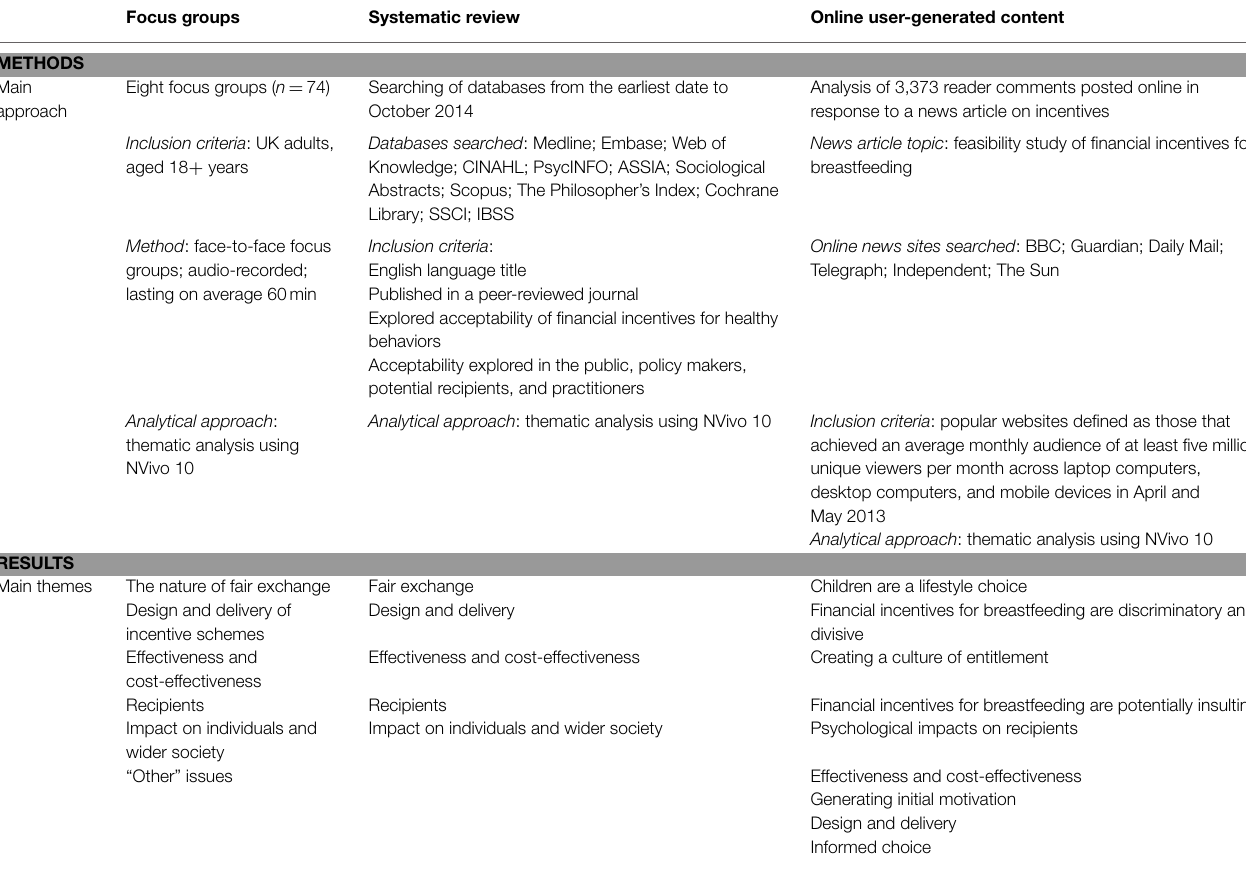
TABLE 1 | Methods and results of three methodological approaches